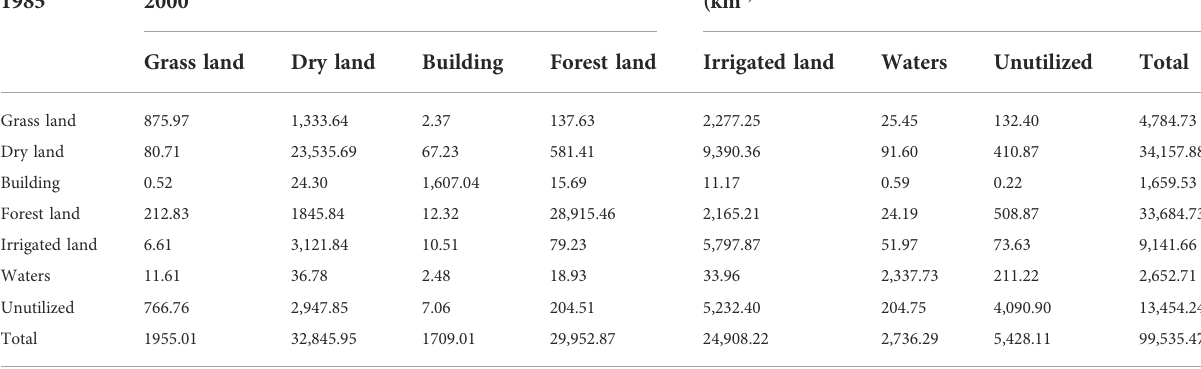
TABLE 4 Land use transition matrixes between 1985 and 2000.